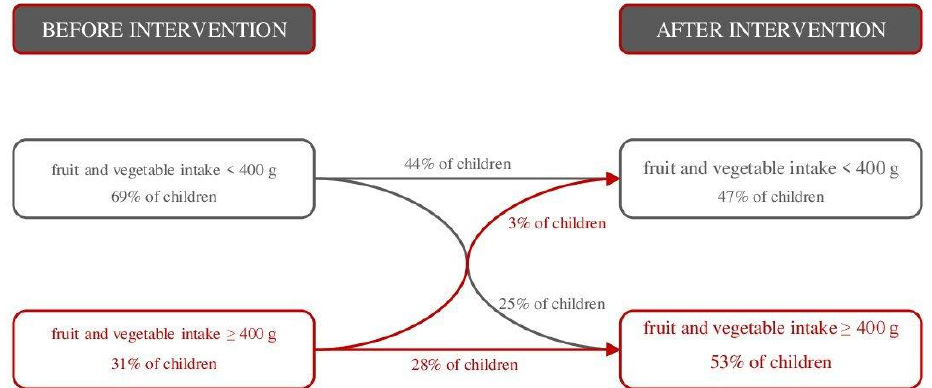
Figure 4. Distribution of children who met recommendation for daily fruit and vegetable intake in the intervention group (n = 143) before and after the